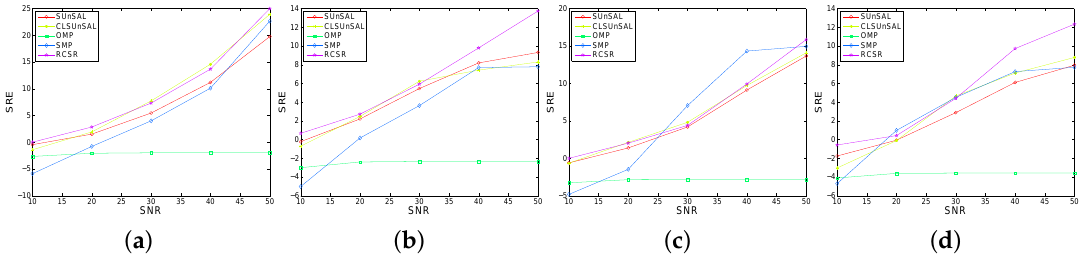
Figure 3. Performance of SRE as a function of SNR under Gaussian white noise when the number of endmembers is four with the ( a ) LMM; ( b ) FM; ( c ) GBM and ( d ) MGBM.